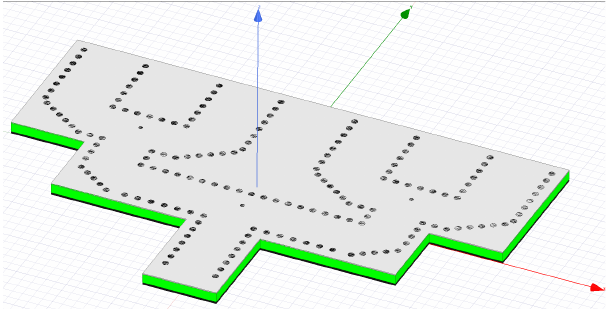
FIGURE 5. The Four-way SIW power divider structure in 3D Figure 5 represents the optimized four-way SIW power divider in 3D